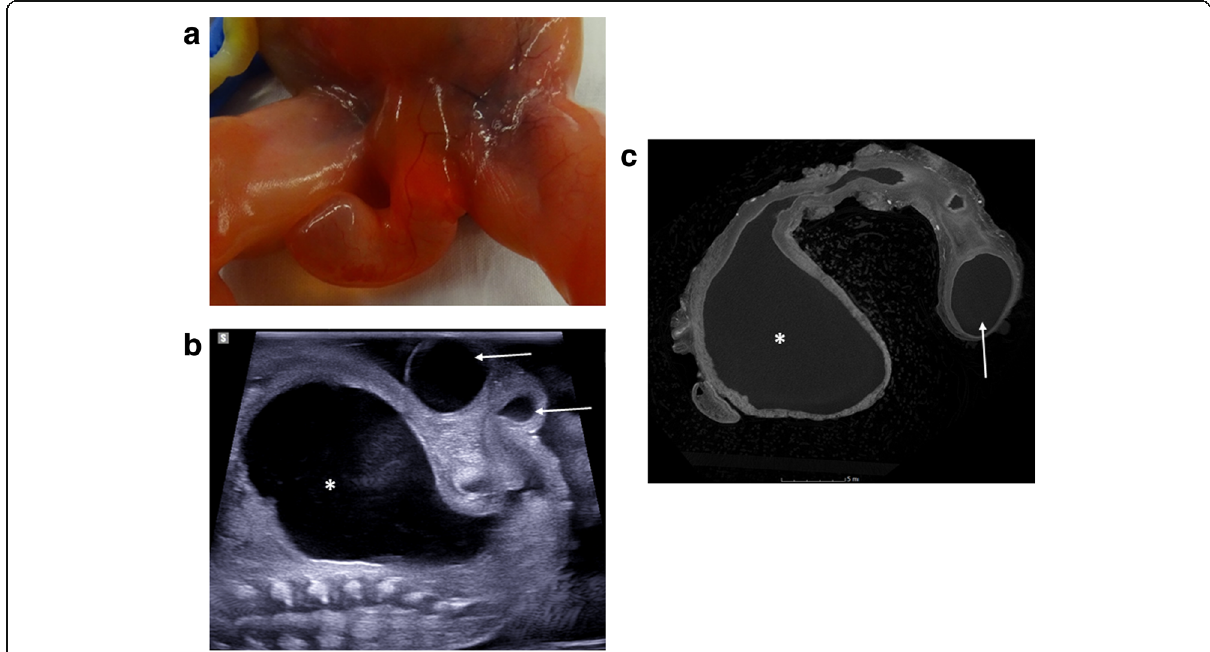
Fig. 19 a – c Megalourethra in a foetus at 18weeks gestation, following termination of pregnancy for bladder outlet obstruction and renal anomalies. A photograph of the perineum ( a ) obtained at external examination demonstrates an enlarged fluid-filled phallus without external meatus. Post-mortem ultrasound imaging of the pelvis in sagittal plane ( b ), acquired 6days after delivery, reveals a distended urinary bladder (asterisk) with a dilated, fluid-filled and tortuous urethra (solid arrows). A subsequent micro-CT study ( c ) was performed of the extracted bladder and urethra prior to histological sectioning, demonstrating the same findings as the ultrasound of a dilated bladder and urethra. In other imaging planes (not shown), the corpus spongiosum was seen to be deficient in keeping with congenital scaphoid megalourethra